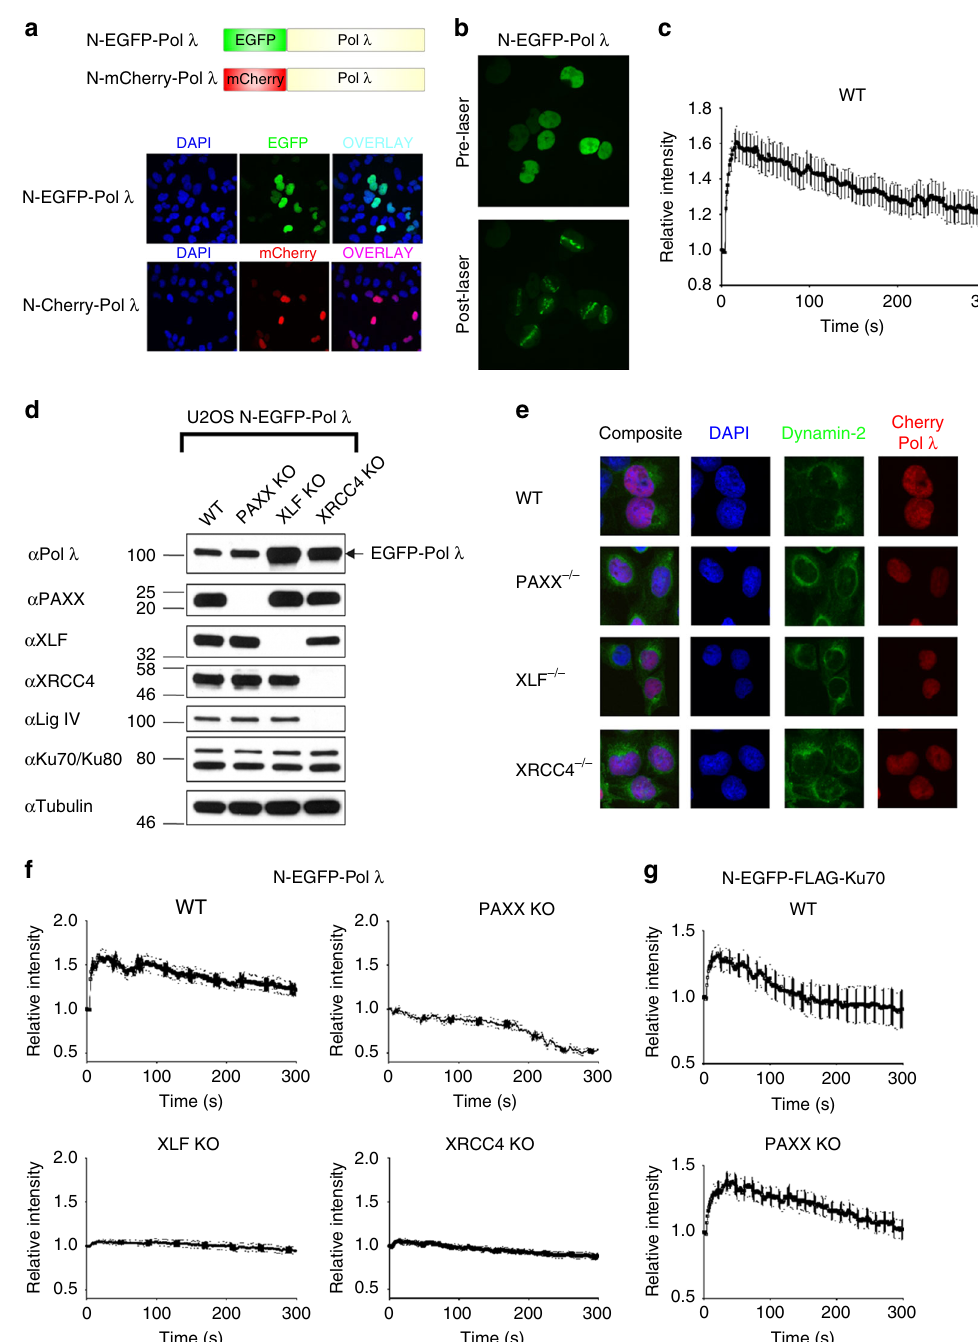
Fig. 5 Role of XRCC4 family members in the recruitment of Pol λ to laser microirradiation-induced DNA damage sites. a Upper, Schematic fi gure showing N-terminal EGFP- and mCherry-Pol λ fusion proteins; Lower, Representative immuno fl uorescence images showing that N-terminal EGFP- and mCherry-Pol λ fusion proteins are localised to nuclei in U2OS cells. b Recruitment of N-terminal EGFP-Pol λ to laser-induced DNA damage sites in U2OS cells. c Time course of N-EGFP-Pol λ recruitment to laser-induced DNA damage sites in U2OS cells. Data shown are the mean and SEM from 16 individual cells. d Immunoblot analysis of N-EGFP-Pol λ expressing U2OS cells de fi cient in PAXX, XLF or XRCC4 generated by CRISPR-Cas9. WCL were resolved by SDS- PAGE and the indicated proteins detected by immunoblotting. e Localisation of N-mCherry-Pol λ in U2OS WT, PAXX-, XLF- and XRCC4-de fi cient cells. Representative immuno fl uorescence images showing that N-terminal mCherry-Pol λ fusion protein localises to nuclei in PAXX-, XLF- or XRCC4-de fi cient U2OS cells. Cells were co-stained with DAPI or dynamin-2, a perinuclear-enriched protein. f Time course of N-EGFP-Pol λ recruitment to laser-induced DNA damage sites in U2OS-WT cells and cells de fi cient in PAXX, XLF or XRCC4. Data shown are the mean and SEM from WT, PAXX, XLF and XRCC4 knockout cells. Graphs shown are for the following cell numbers: WT: 8 cells; PAXX KO, 10 cells; XLF KO 17 cells; XRCC4 KO 18 cells. g Time course of N-EGFP-FLAG-Ku70 recruitment to laser-induced DNA damage sites in U2OS-WT cells and PAXX KO cells. Data shown are the mean and SEM from WT and PAXX knockout cells. Graphs shown are for the following cell numbers: WT: 17 cells; PAXX KO, 19